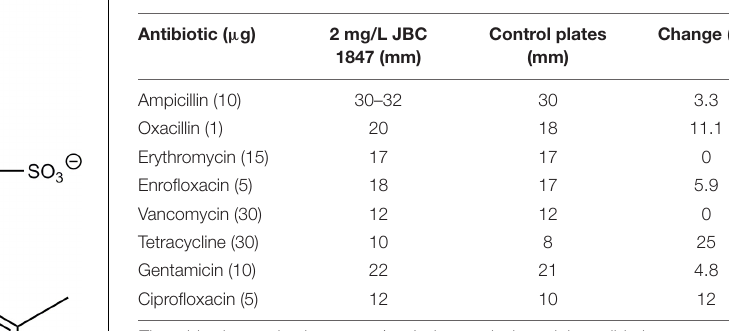
TABLE 2 | JBC 1847 activity against Staphylococcus aureus ATCC-BAA 1556 in presence of eight